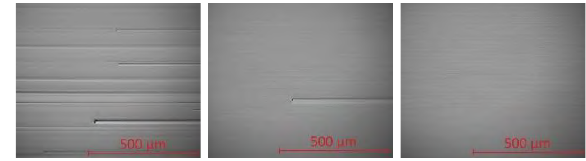
Fig . 11 . Microscopic view in depths 7.5 µm, 15 µm and 22.5 µm respectively of the V-shape polished surface grinded with the D30 tool.